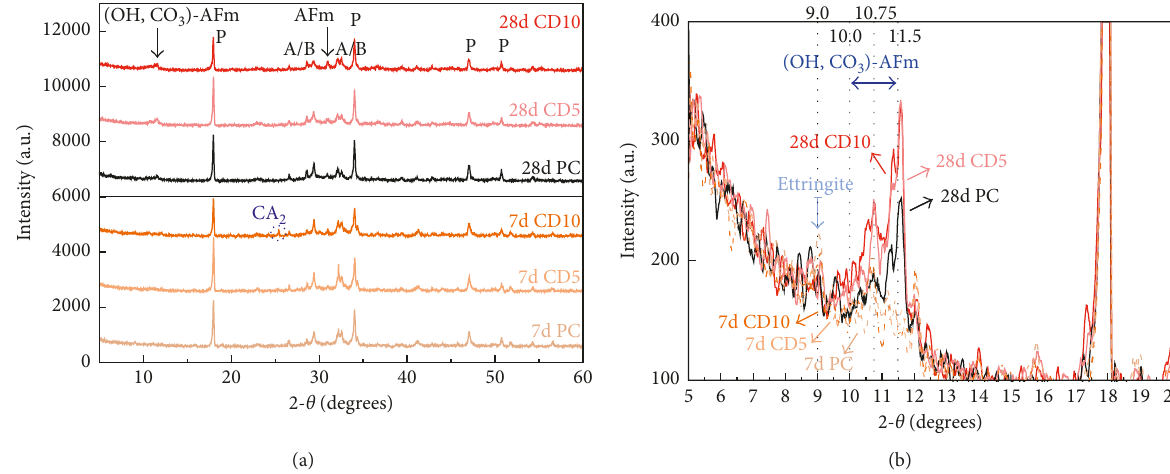
Figure 9: XRD patterns of PC, CD5, and CD10 reacted with distilled water at 7 and 28 days. (a) The XRD patterns between 5 ° and 60 ° . (b) The XRD patterns between 5 ° and 20 ° ; P: Ca(OH) 2 , A/B: C 3 S and C 2 S, and AFm: AFm